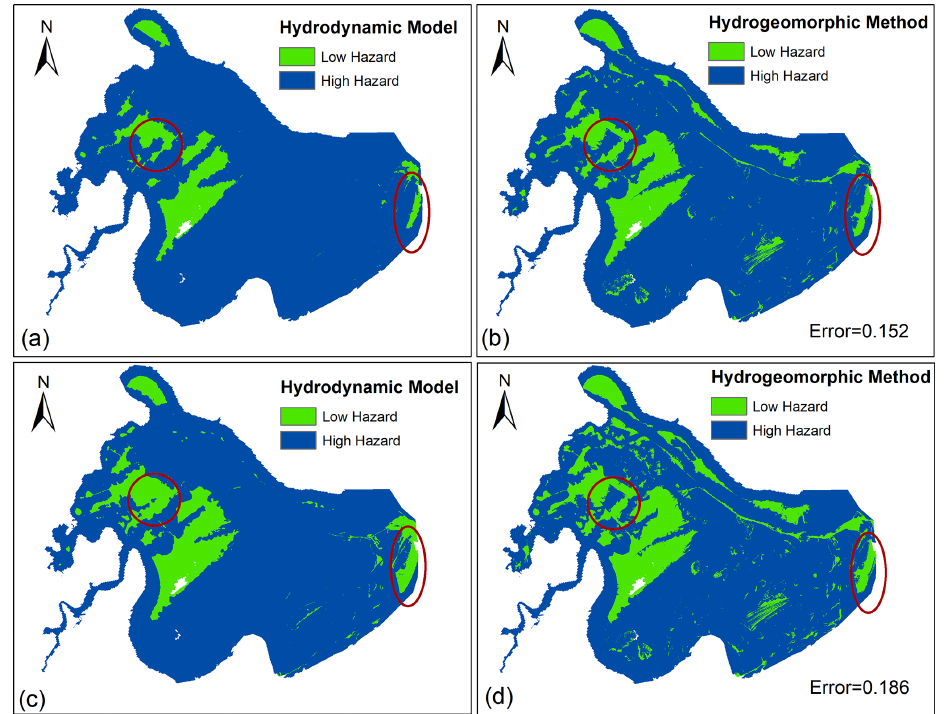
Figure 8. Validation results for Hurricane Irma showing a side-by-side comparison of flood hazard maps generated by the hydrodynamic model and hydrogeomorphic method for two different hazard depth cutoffs (HDCs): HDC = 0 (a, b) and HDC = 0.6m (c, d) . To generate the flood hazard maps by the hydrogeomorphic method, the operative curves estimate two hydrogeomorphic thresholds of 0.1 and 0.08 for HDC = 0m and HDC = 0.6m, respectively, and the return period of Hurricane Irma is estimated as a 223-year flood